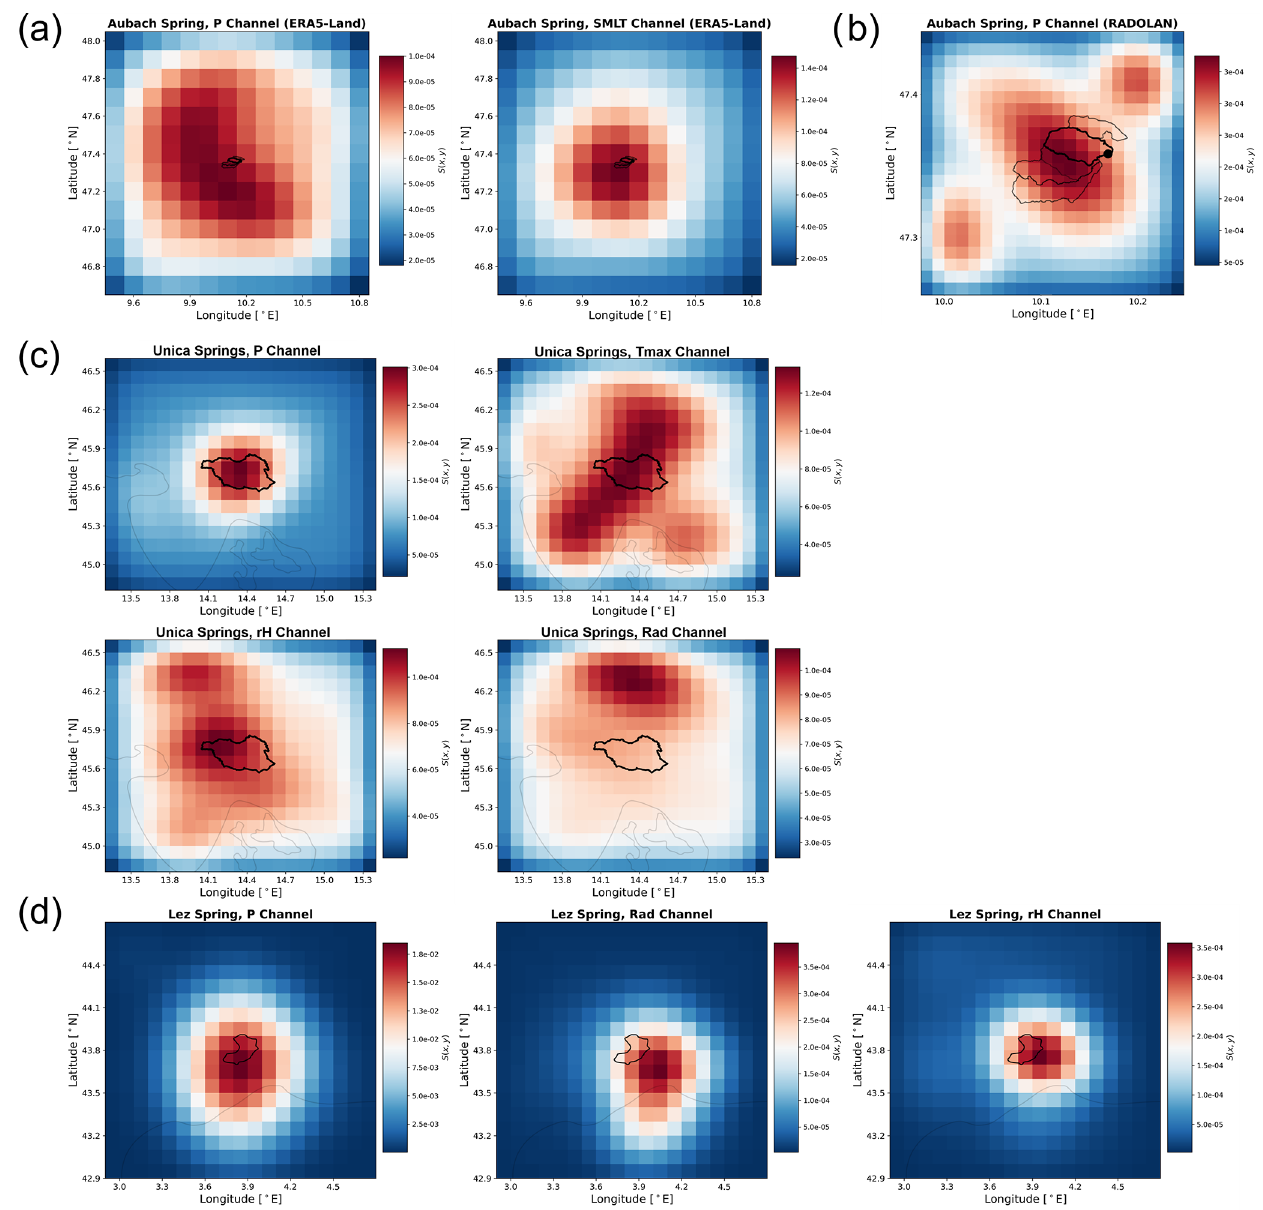
Figure 6. Heat maps of spatial input sensitivity for Aubach spring based on ERA5-Land gridded data (a) and for Aubach spring based on RADOLAN precipitation data (b) , Unica springs (c) and Lez spring (d) , both based on E-OBS gridded data. In the case of (c) and (d) , light-grey lines indicate the coastlines for